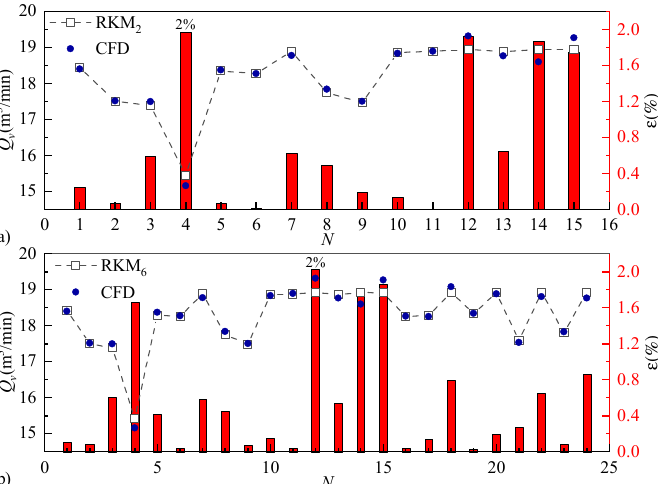
Figure 12. The prediction results of the sample points by RKM in the improvement stage: ( a ) the sample after the second filling; ( b ) the sample after the sixth filling. Table 7. Filling process in the improvement